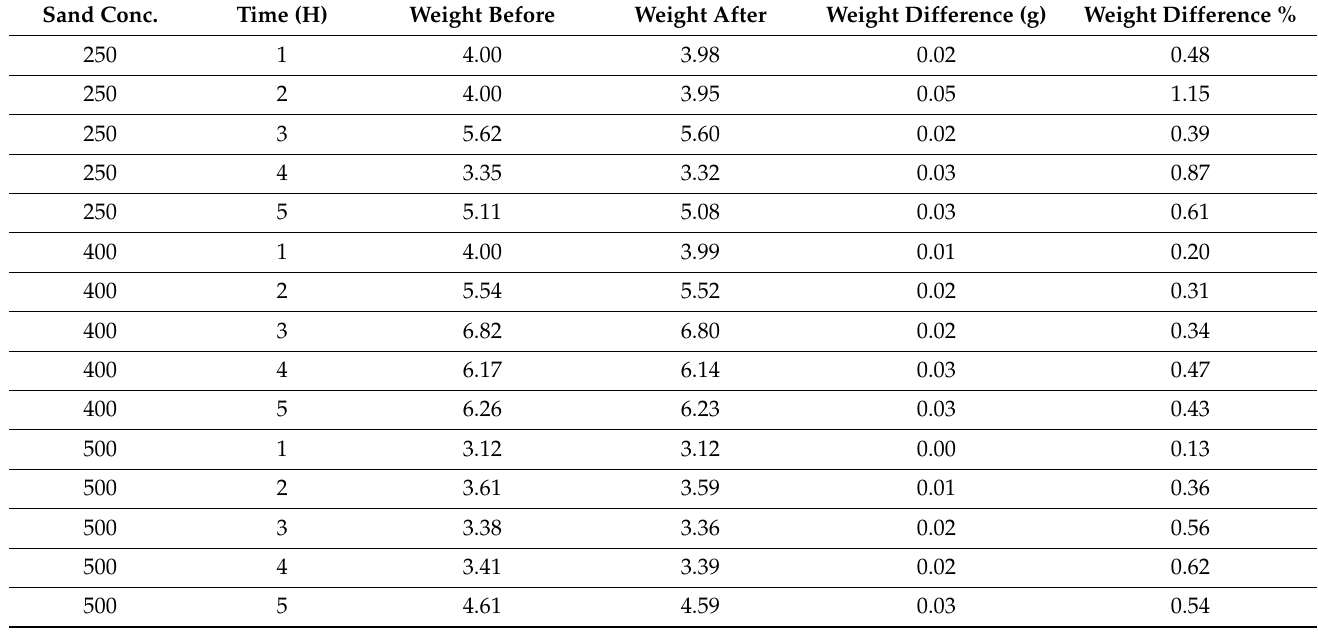
Table 1. Test data at a flow rate of 0.01 m 3